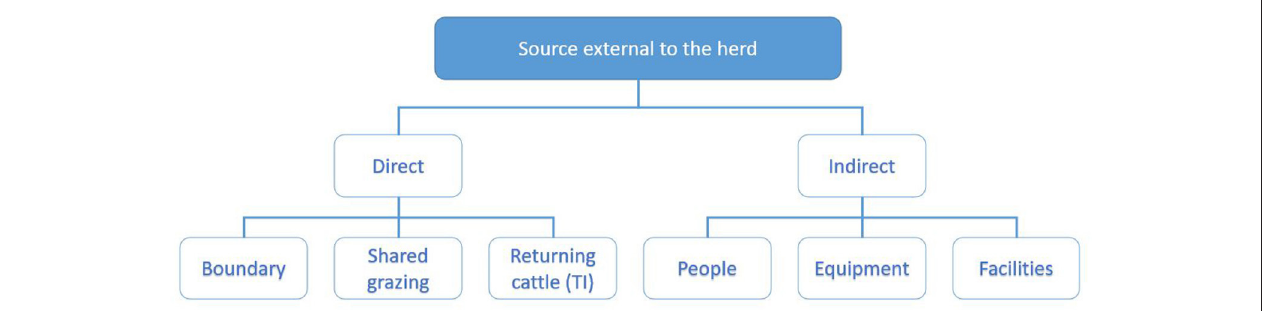
FIGURE 4 | Categorisation of potential sources of infection external to the herd explored during the investigation. Direct sources of infection include boundaries (20), shared grazing (11) and returning cattle (15). Indirect sources include people, equipment and facilities (7, 8).